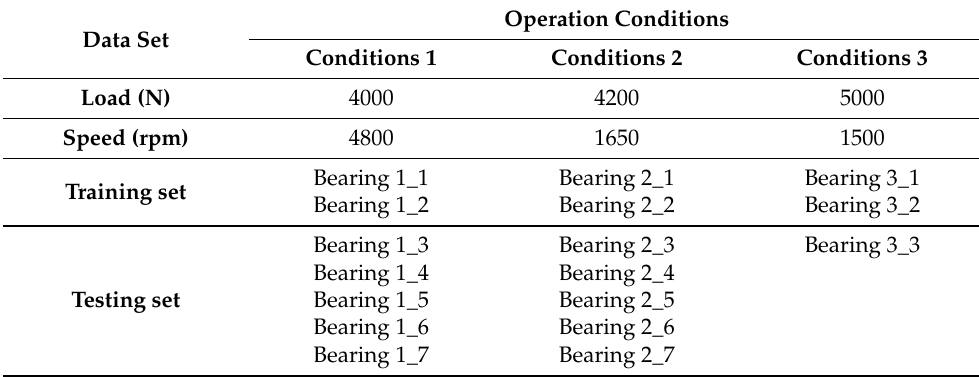
Table 1. Datasets of IEEE PHM 2012 prognostic challenge.